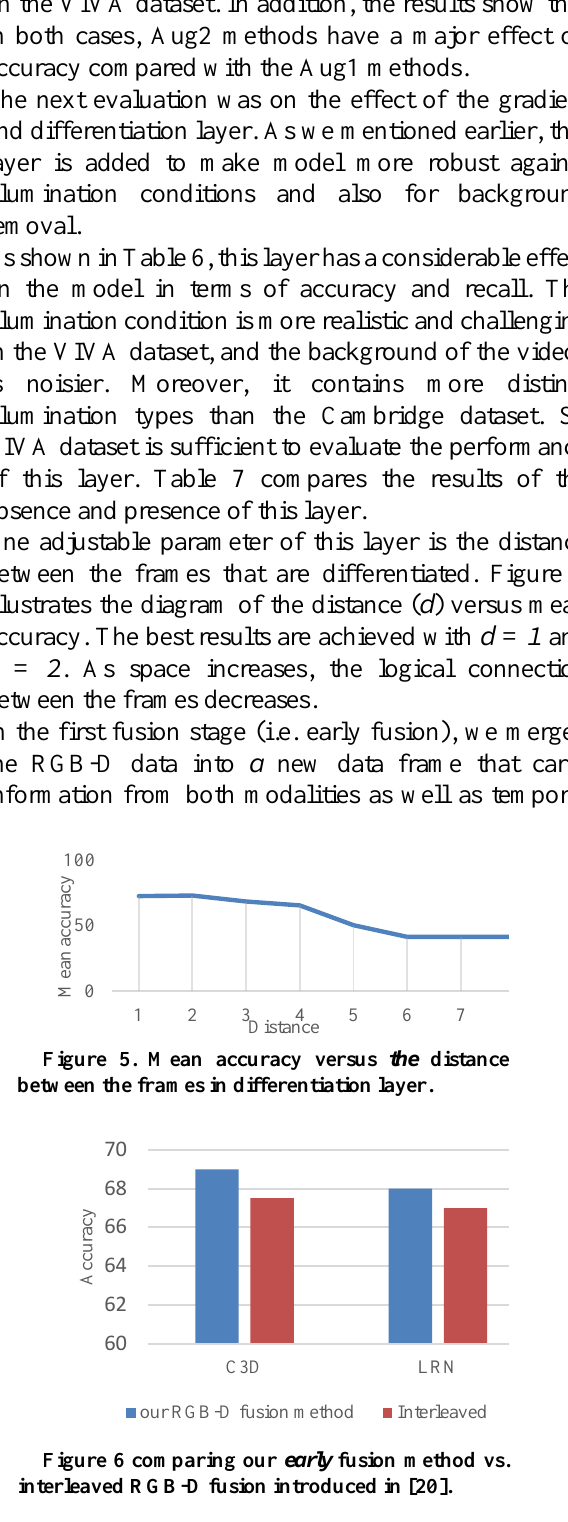
Table 4. . Mean and standard deviation of accuracy and recall. T1 and T2 represent the training and testing times, respectively. std: standard deviation.